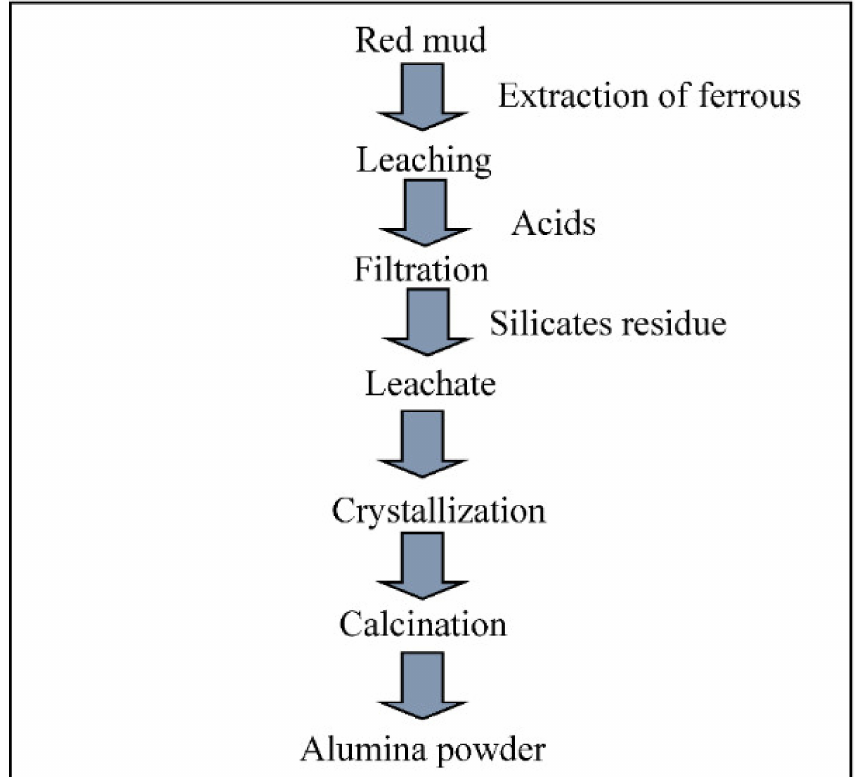
Figure 5. Flow chart for the recovery of alumina from red